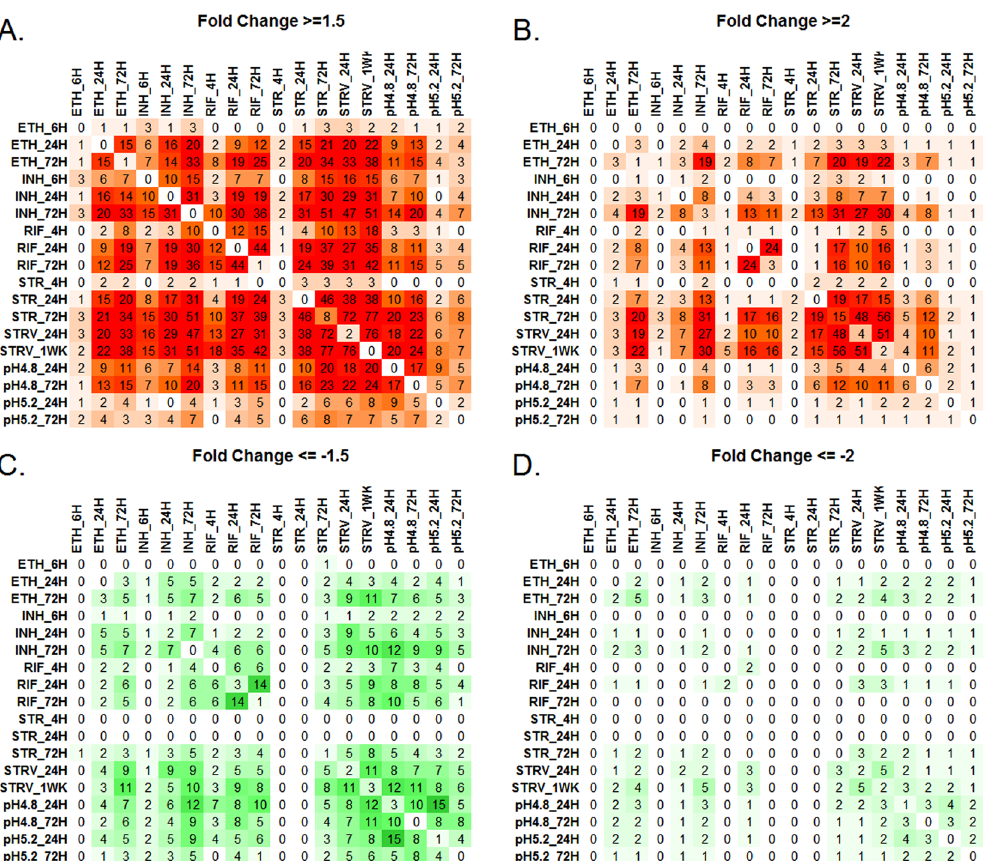
Figure 3. Differential gene expression matrix showing the number of up and down regulated TA genes across the experimental conditions. TA genes up and down regulated at varying sensitivity of detection were subjected to GeneMatrix software which resulted in distribution of up and down regulated genes across 18 conditions profiled. The upregulated genes at 1.5 FC ( A ) and 2.0 FC ( B ) are shown in increasing color of red while the downregulated genes at 1.5 FC ( C ) and 2.0 FC ( D ) are shown in